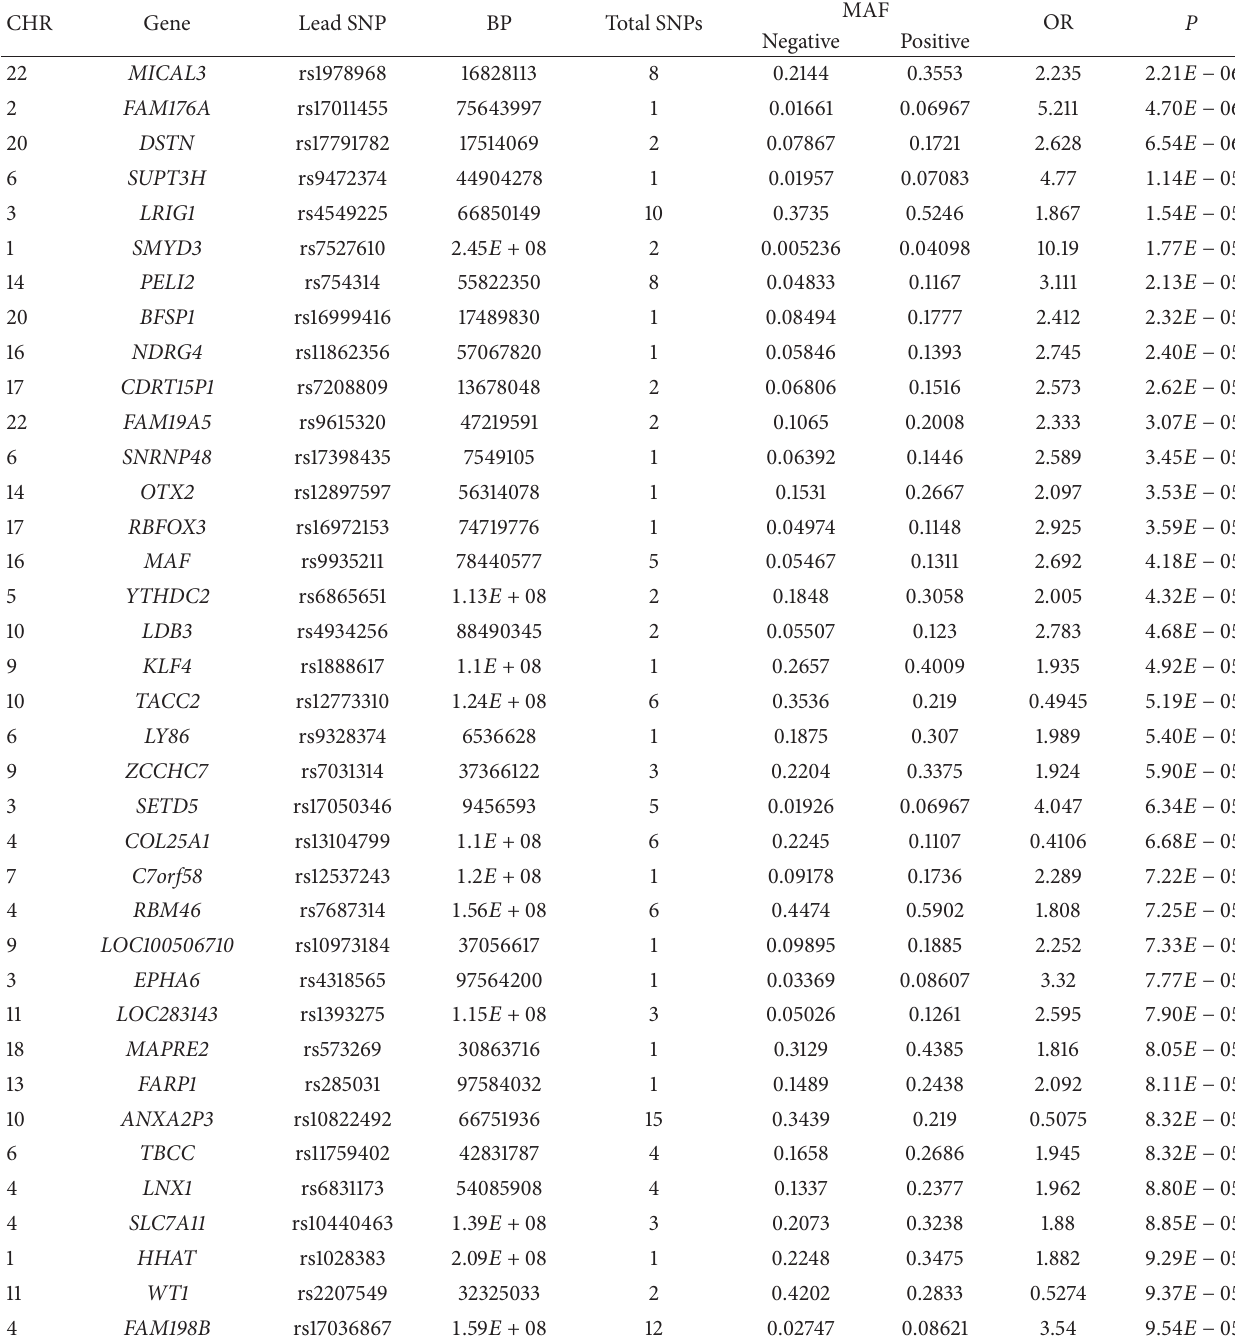
Table 3: Genetic loci associated with the occurrence of lupus anticoagulant (LAC) with 𝑃 < 1𝐸 − 04 ∗